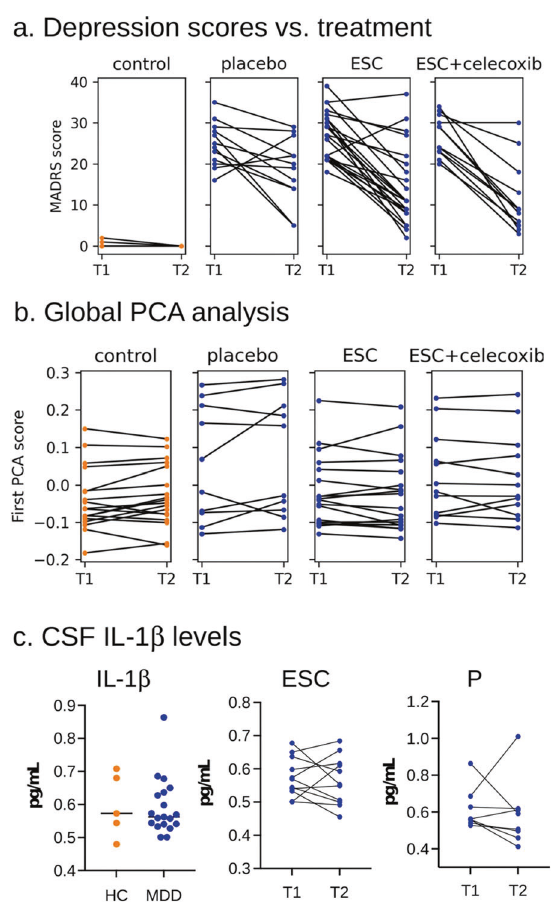
Fig. 3 Temporal analysis of depression scores, CSF IL-1 β levels, and integrated biomarkers. a MADRS scores at baseline and fi nal visit. MDD patients in all groups saw signi fi cant improvement to MADRS scores (Wilcoxon signed-rank test, escitalopram p < 0.001 in n = 23, escitalopram and celecoxib p = 0.003 in n = 12, and placebo p = 0.034 in n = 12, healthy controls n = 23). In addition, the patients receiving escitalopram (either with or without celecoxib) saw a signi fi cant improvement over patients receiving placebo (ANCOVA p = 0.030, effect size = − 6.34 (SE = 2.8) points, n = 35 with escitalo- pram, n = 12 placebo). b Integrated in fl ammatory biomarker signa- ture at baseline compared with a fi nal visit in the treatment and control cohorts. The scores for the top principal component were computed from in fl ammatory biomarker concentrations measured at T1, and then scores from T2 measurements were computed by projection according to T1 loadings. No signi fi cant changes were observed in any groups (Wilcoxon signed-rank test p > 0.1 for all treatments; n = 18 control, n = 10 placebo, n = 18 escitalopram (ESC), n = 12 ESC + celecoxib) and individuals ’ scores were highly consis- tent. T1 = start of therapy; T2 = after 8 weeks of therapy. c IL-1 β levels are low in CSF and do not change with treatment for depression. IL- 1 β levels in the CSF were measured by dELISA in 5 HC (orange) and 19 individuals with MDD (blue). The median level is N.S. ( p = 0.688, Wilcoxon rank-sum test); CSF IL-1 β levels do not change following treatment with ESC (20 mg/day × 8 weeks, p = 0.638, Wilcoxon signed-rank test); Lines interconnect samples from the same patient drawn at T1 and T2. CSF IL-1 β levels do not change following treatment with placebo (P, p = 0.461, Wilcoxon signed-rank test); CSF cerebrospinal fl uid, HC healthy control, MDD major depressive disorder, ESC escitalopram, P =